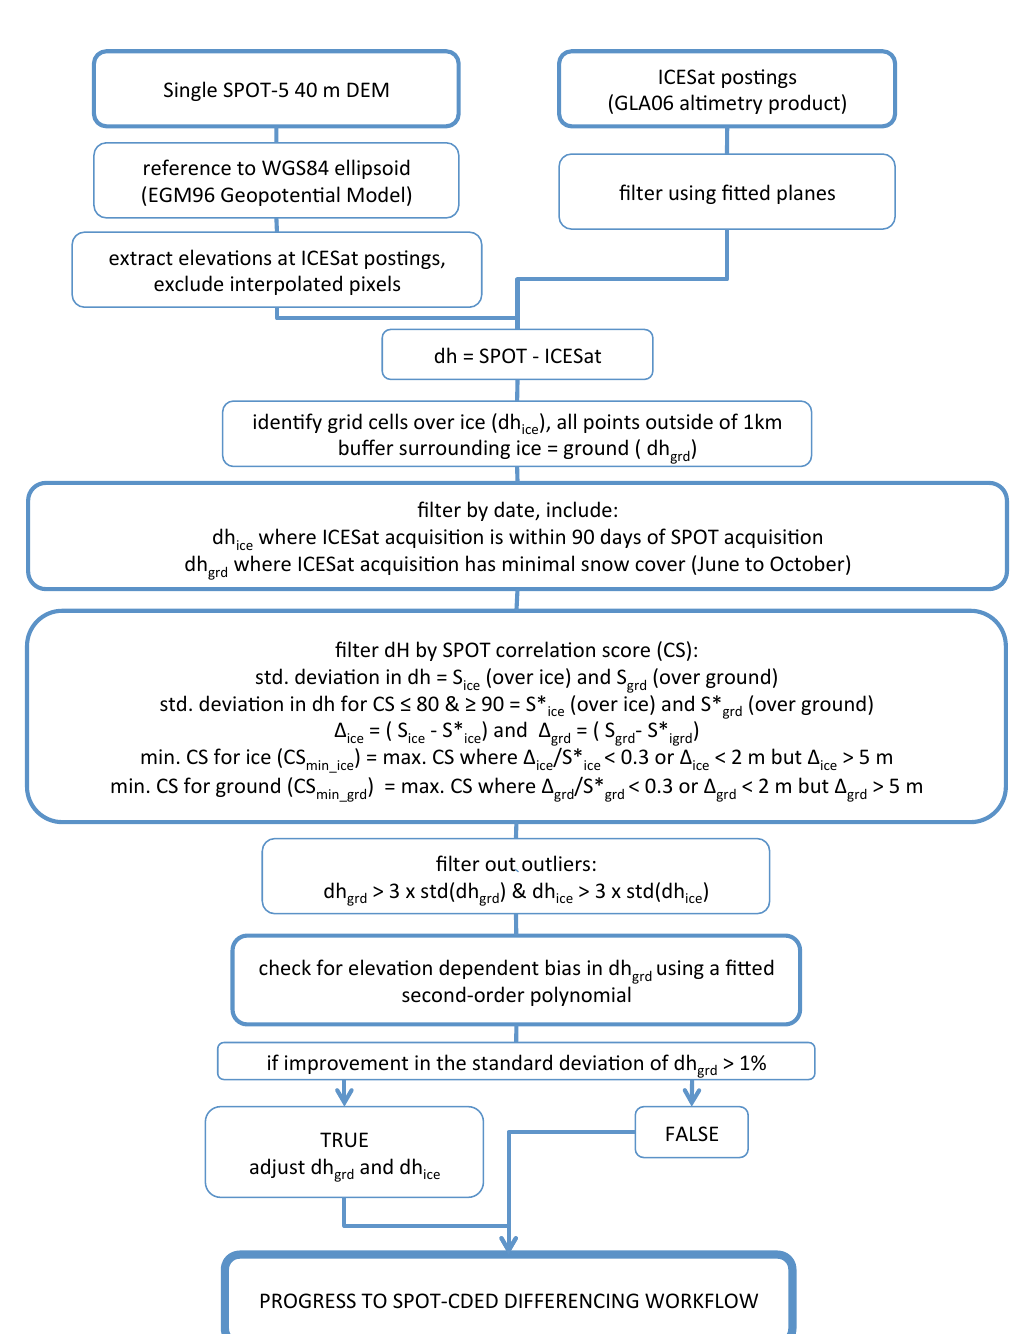
Fig. A1. Workflow for SPOT DEM validation and filtering using ICESat altimetry.